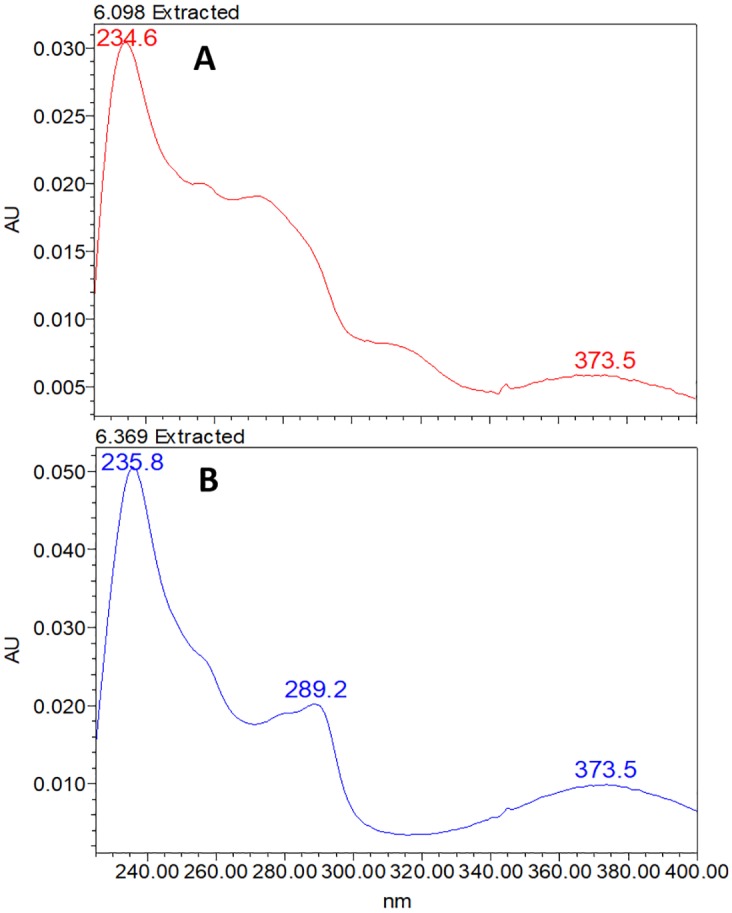
Spectrum extracted from peaks observed in Fig 1B.The spectrum was extract from the respective retention times of the peaks observed in Fig 1B. (A) Spectrum from peak 1 (6.098 min); (B) spectrum from peak 2 (6.369 min).